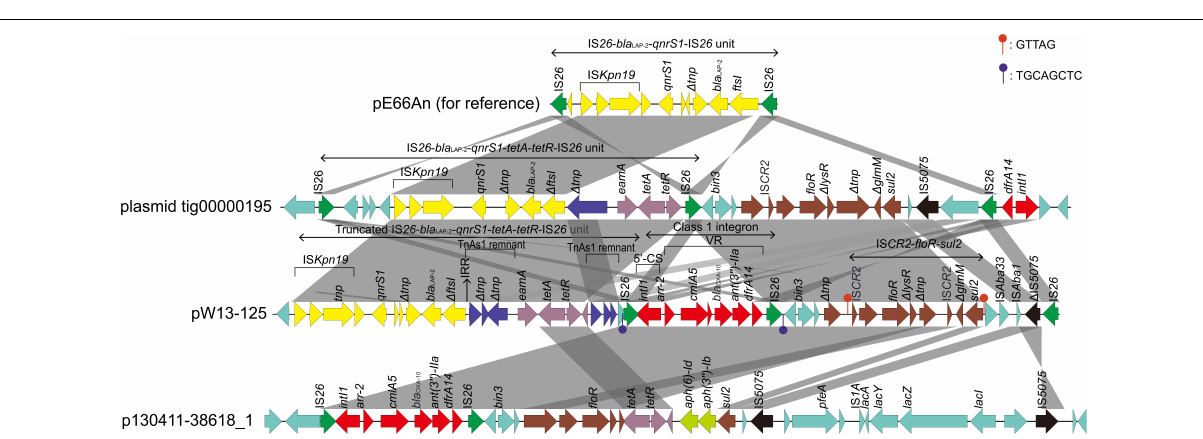
FIGURE 4 | Comparison of the MDR region of pW13-125 with the related regions on the other plasmids. Genes are denoted by arrows and colored according to gene function classification. Shading indicates the homologous regions. The detected direct repeat sequence is marked in the upper right